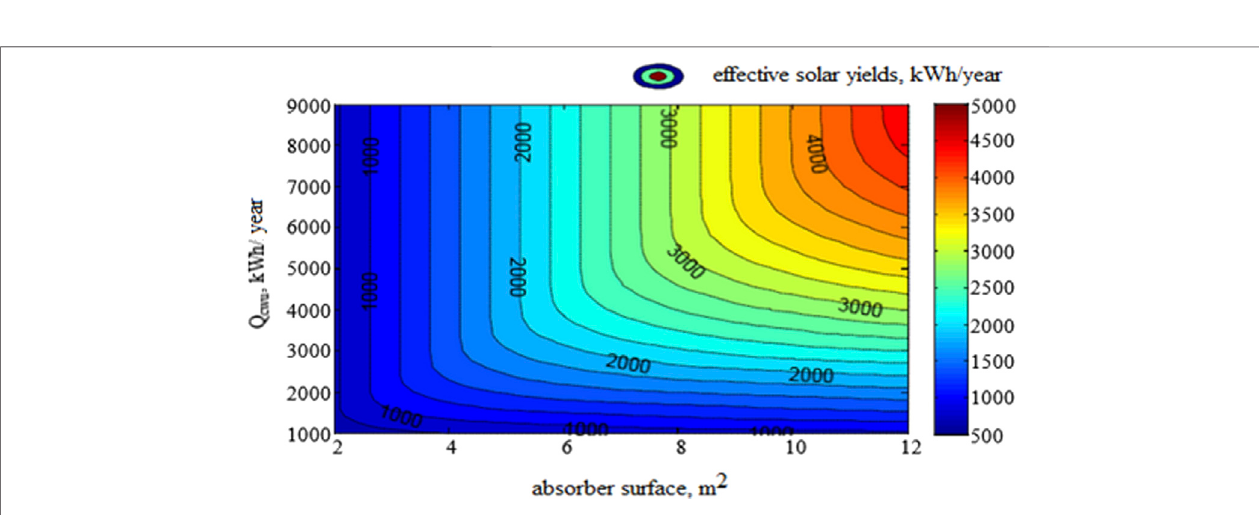
Frontiers in Energy Research |